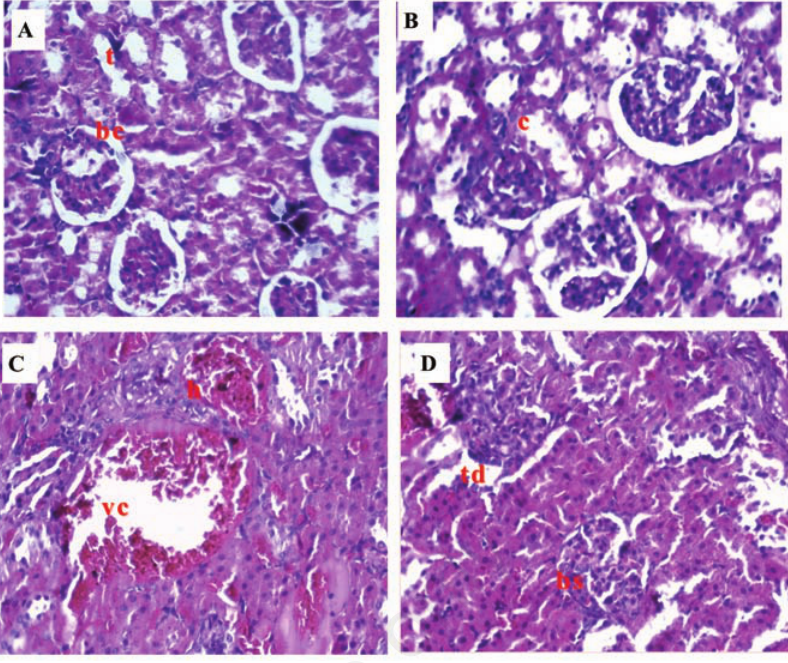
Figure 4. Hematoxylin and eosin staining after administration of lambda-cyhalothrin (LCT) for 28 days (original magnification 400×). A) Group treated with 0 mg/kg of LCT, showing normal architecture, renal corpuscles with Bowman’s capsules (bc), and normal proximal and distal convoluted tubules (t); B) group treated with 20.4 mg/kg of LCT, showing a normal cortex; C) group treated with 30.6 mg/kg of LCT, showing vascular congestion (vc) and hemorrhage (h); D) group treated with 61.2 mg/kg of LCT showing narrowed Bowman’s space (bs) and extensive tubular dilatation (tb). Changes increased in a dose-dependent manner.